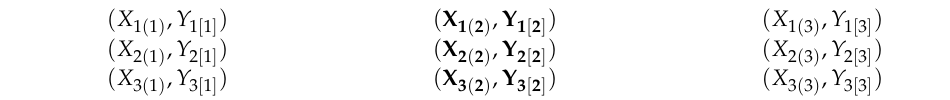
Table 2. MRSS for odd sample size i.e., n δ =